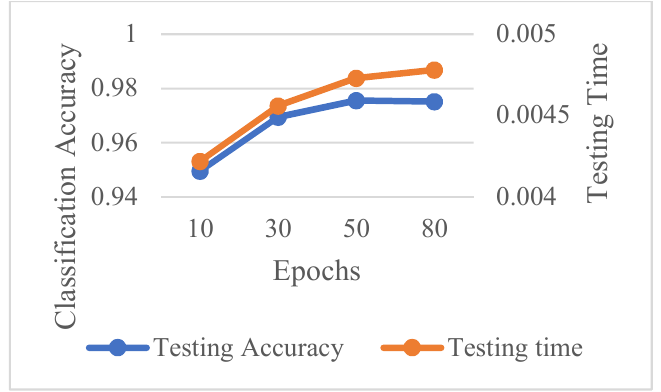
Figure 6. Accuracy and computation time at different mini-batch sizes.